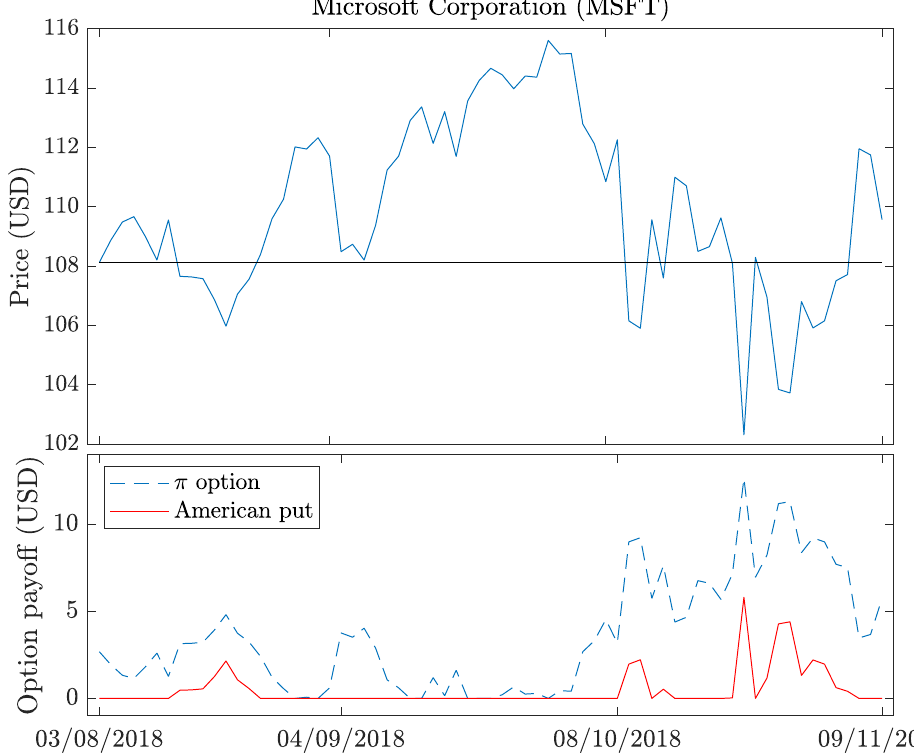
Figure 10. Microsoft Corporation stock closing prices ( top ) and the corresponding payoffs of π -option on relative drawdown and American put ( bottom ) with the parameters from Table 4.